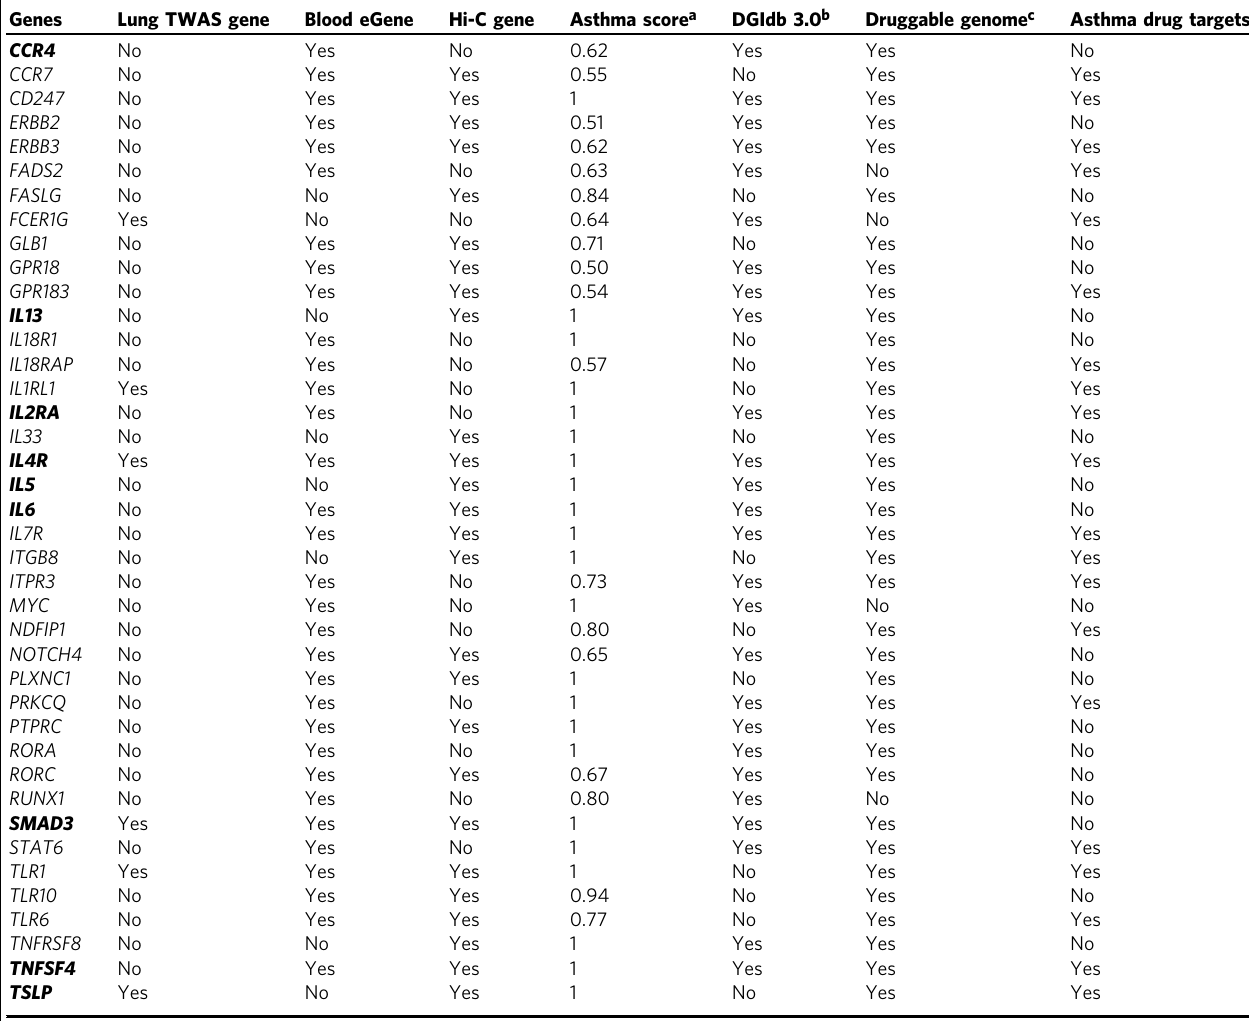
Table 4 Genes prioritized as therapeutic targets for asthma in alphabetic order. Genes Lung TWAS